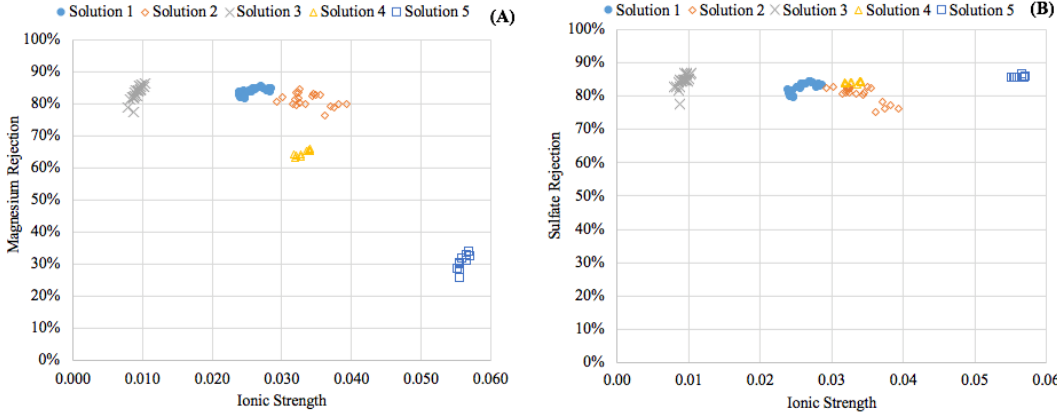
Figure 4. Effect of ionic strength on ion removal. ( A ) Magnesium; ( B ) Sulfate.